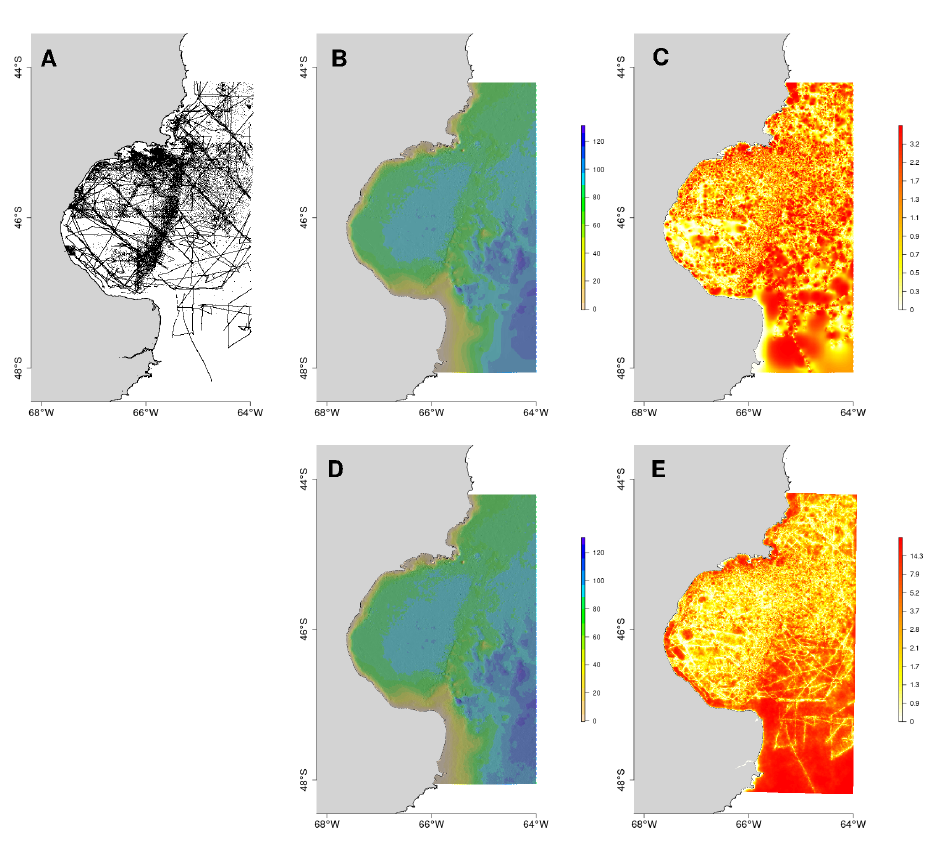
Figure 3. ( A ) Bathymetric acoustic sounding points and transects in the Gulf of San Jorge; ( B ) MMI interpolated bathymetry ( ˆ f CV ); ( C ) Cross-validation local standard error ∆ ˆ f CV . ( D ) and ( E ) have, respectively, the same meaning but including fractal extrapolation in the